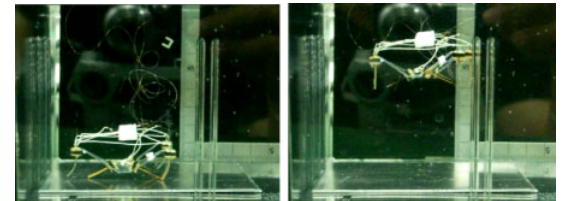
Figure 9 Two views of the floating motion